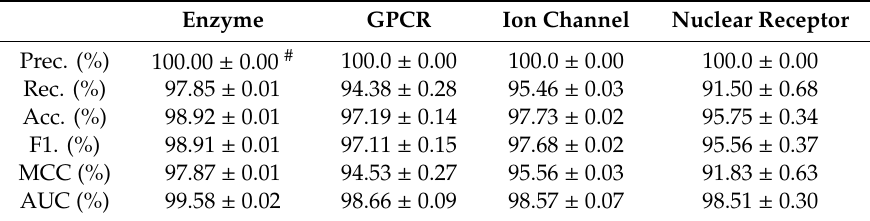
Table 1. Results of proposed method. Prec., Rec., Acc., F1., MCC and AUC are short for precision, recall, accuracy, F1-scores, Matthews Correlation Coefficient and Area Under ROC-curves.